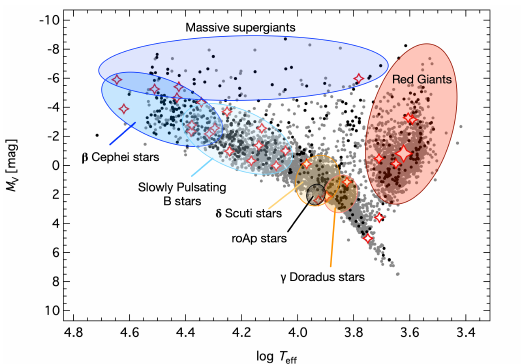
Figure 12. HR diagram of the stars brighter than 6th mag in V (grey dots). Stars for which BRITE photometry was collected are shown by black dots. The objects discussed in Section 4 are marked as open red symbols where the larger symbol stands as a representation of the 23 red giants discussed in Section 4.15. Indicative instability domains for several types of pulsators are shown as colored ellipses. Be stars cover much of the β Cep and SPB